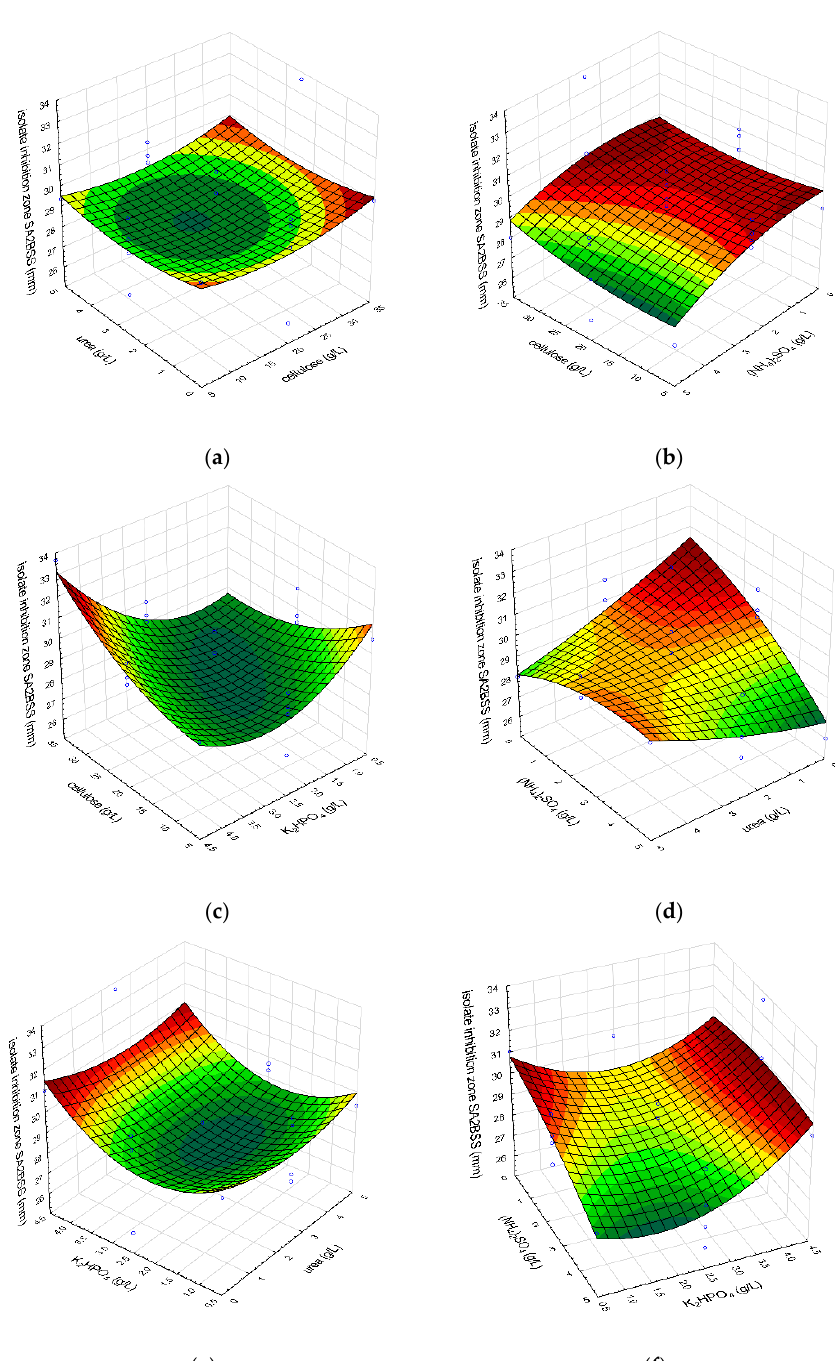
Figure A1. Response surface plots for effects of nutrients’ content on inhibition-zone diameter for Aspergillus flavus SA2BSS (RSM methodology): ( a ) cellulose and urea, ( b ) cellulose and (NH 4 ) 2 SO 4 , ( c ) cellulose and K 2 HPO 4 , ( d ) urea and (NH 4 ) 2 SO 4 , ( e ) K 2 HPO 4 and urea, ( f ) K 2 HPO 4 , and (NH 4 ) 2 SO 4 .